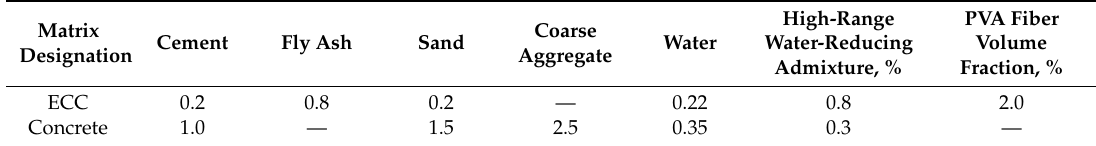
Figure 2. Specimen details (units: mm). Table 1. Mixture proportions.